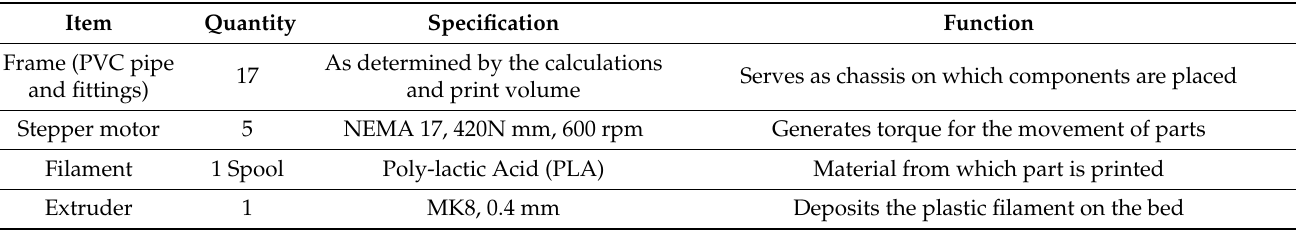
Table 1. Component and material used for the fabrication of the 3D printing